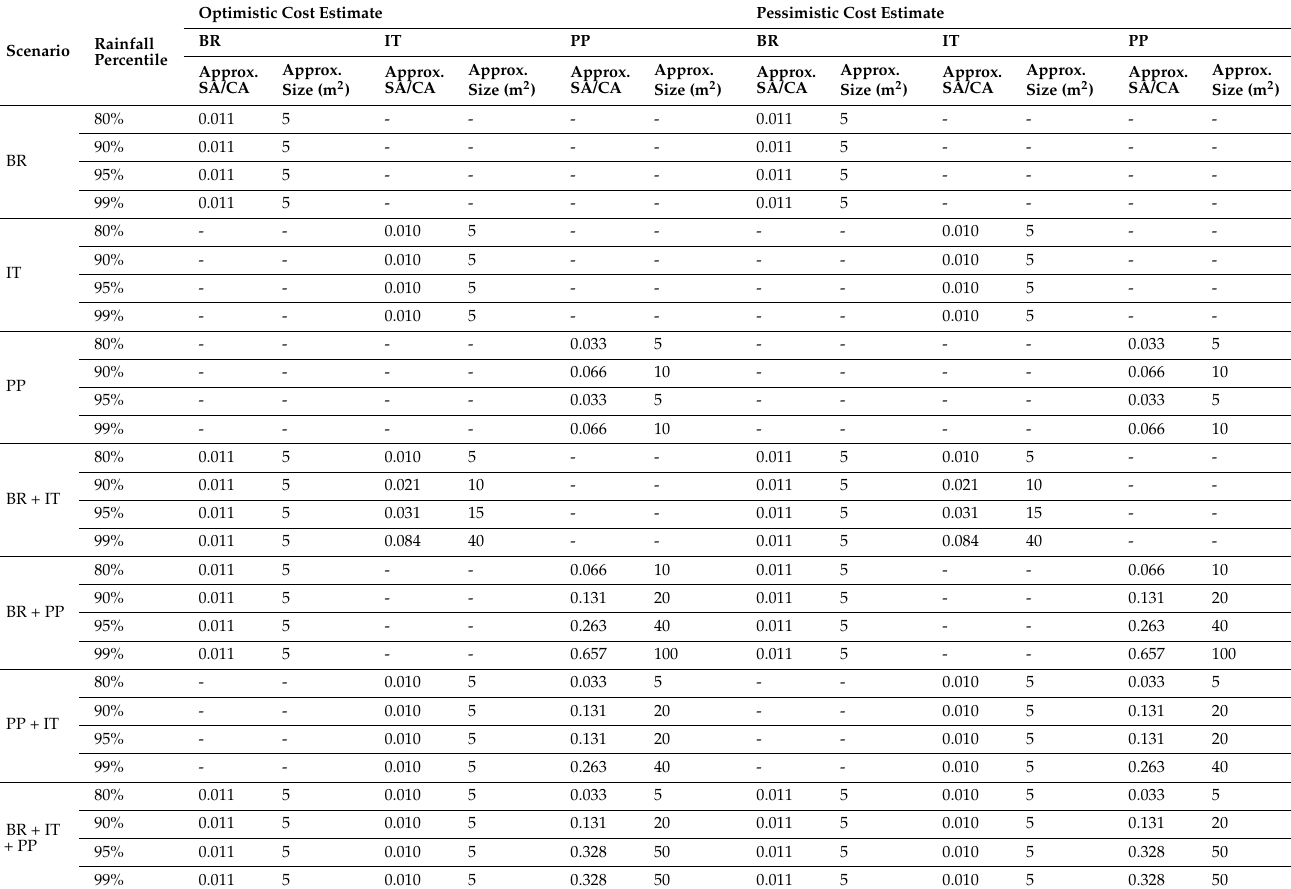
Table 4. Sizing of the optimal scenarios using optimistic and pessimistic cost